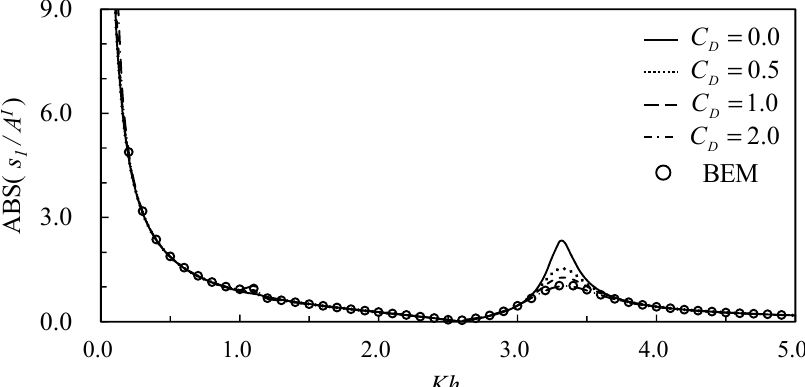
Figure 10. Heave motion amplitude versus relative water depth for various drag coefficients ( 25.0 1